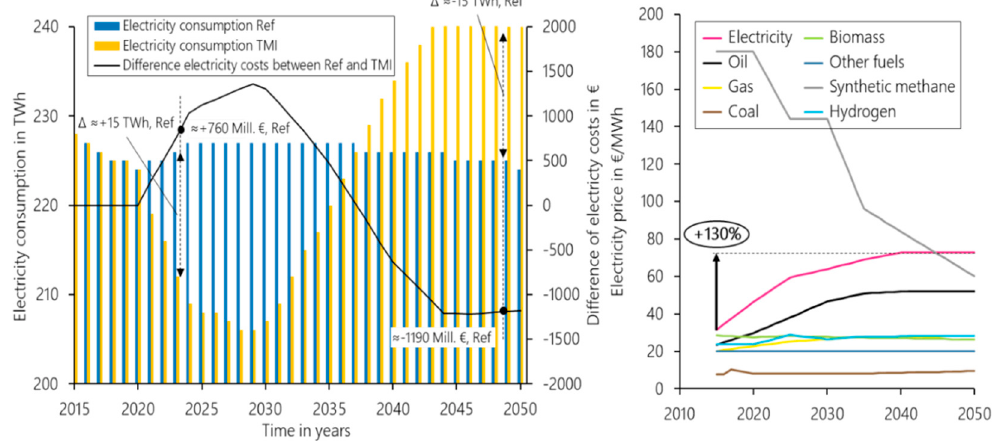
Figure 11. Left: Development of electricity consumption in the Ref and TMI scenarios and difference in electricity costs between them. Right: Endogenic energy prices of ISAaR used in both scenarios.